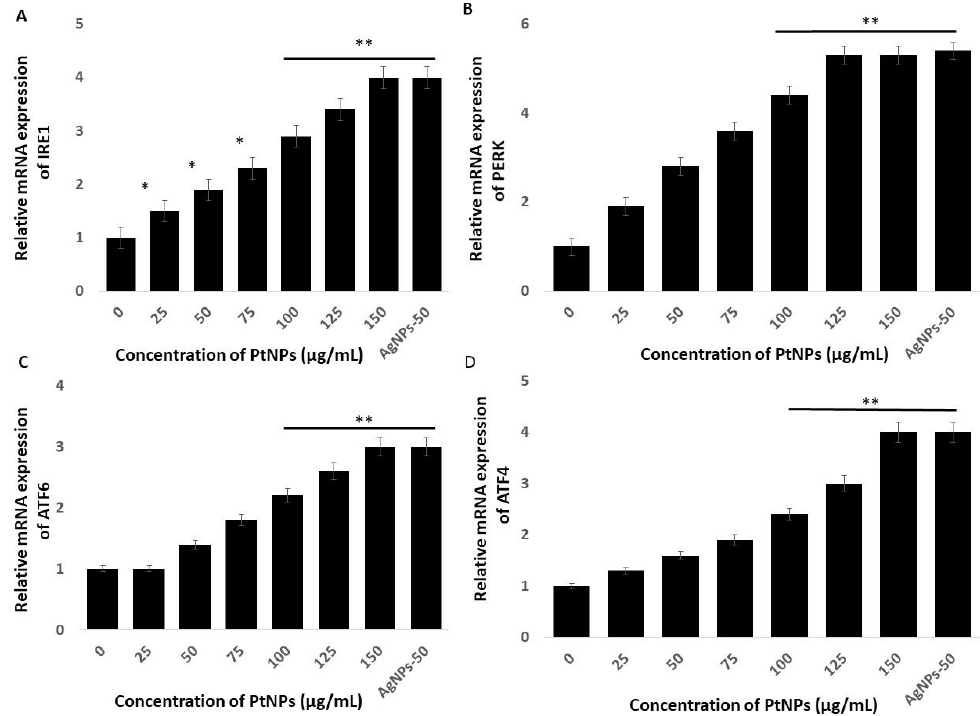
Figure 8. PtNPs enhance the expression of endoplasmic reticulum stress (ERS) genes. THP-1 cells were treated with various concentrations of PtNPs (25–150 µ g / mL) for 24 h. The messenger RNA (mRNA) expression of ERS genes ( A ) inositol-requiring enzyme 1 (IRE1), ( B ) PKR-like ER kinase (PERK), ( C ) activating transcription factor 6 (ATF6), and ( D ) ATF4 was analyzed using quantitative reverse-transcription polymerase chain reaction. After 24 h, the fold change in the expression was determined relative to GAPDH expression. Results are expressed as mean fold change ± standard deviation from three independent experiments. The treated groups showed statistically significant di ff erences from the control group by the Student’s t -test (* p < 0.05; ** p < 0.01). * significant; ** highly